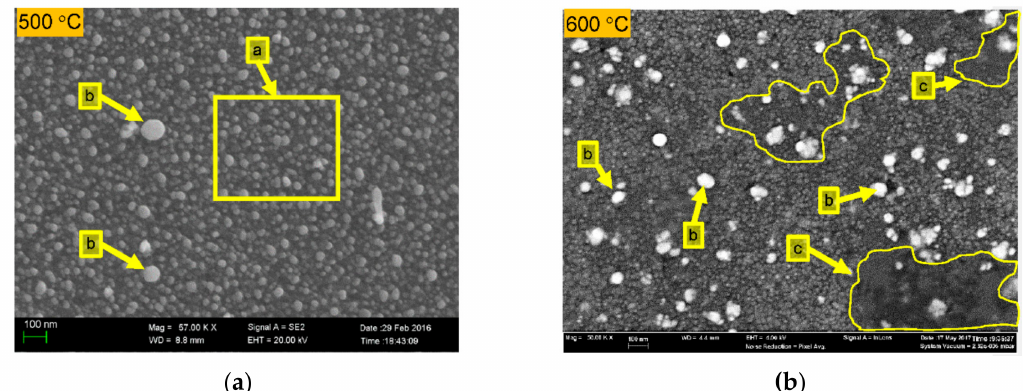
Figure 9. ( a ) SEM micrograph of CuIC micro-Si thin film with (n-type C-Si wafer / p-type Si / Cu) structure after annealing at 500 ◦ C, ( b ) SEM micrograph of the CuIC micro-Si thin film after annealing at 600 ◦ C.